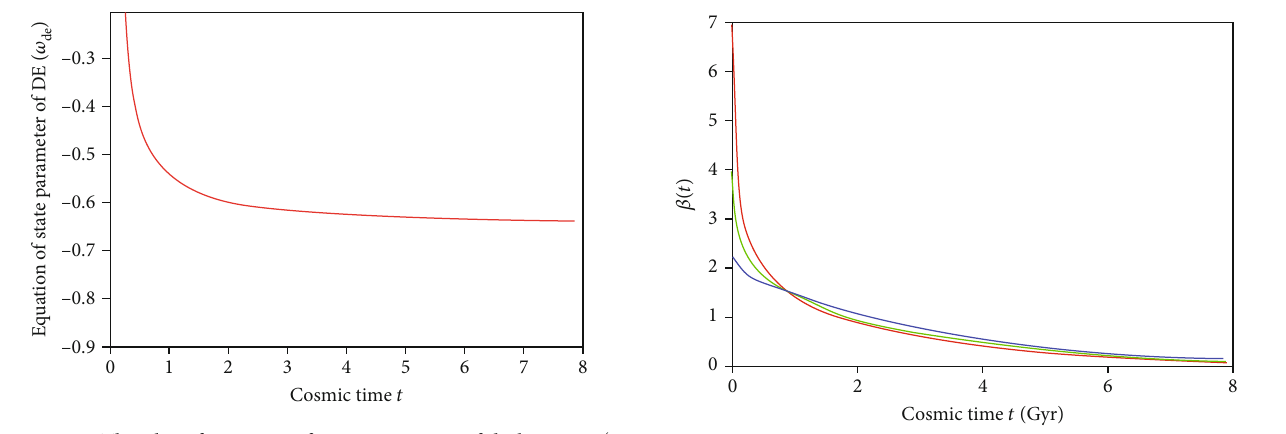
Figure 5: The plot of equation of state parameter of dark energy ð Þ versus cosmic time t for constants l = 1 : 5 , n = 2 , k = 0 : 5 , m ω de 0 : 5 , α = 0 : 5 , and γ = 0 : 6 .